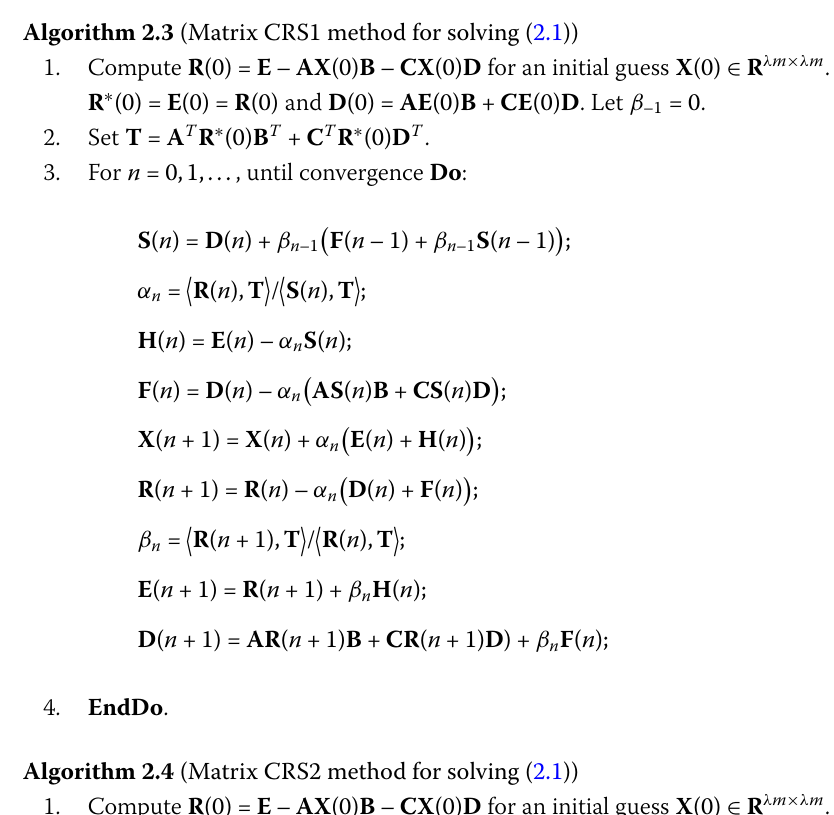
Algorithm 2.3 (Matrix CRS1 method for solving (2.1))